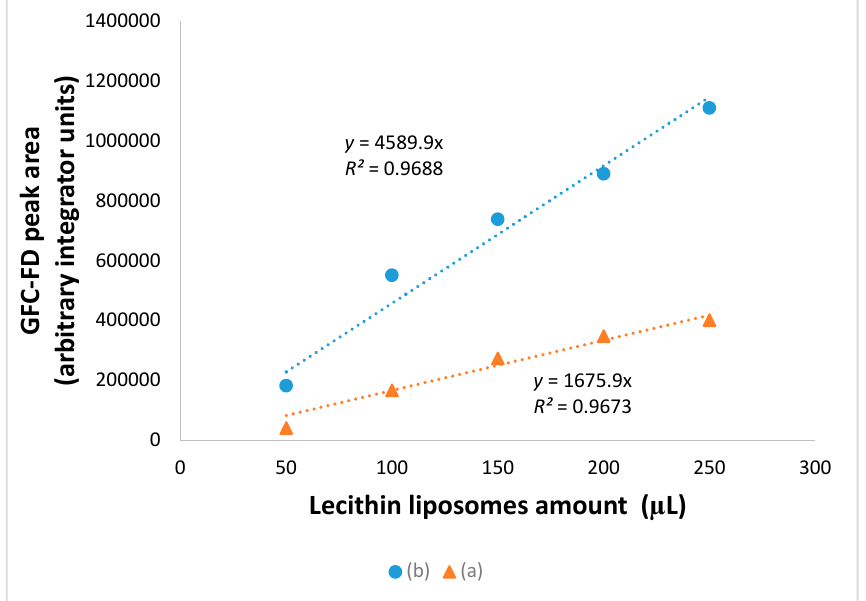
Figure 10. Optimization of lecithin liposomes amount added to ( a ) distilled deionized water, and ( b ) TiO 2 nanoparticles (1.0 mg/mL), in extended GFC analysis using λ ex,max = 350 nm and λ em,max = 395 nm for FD.